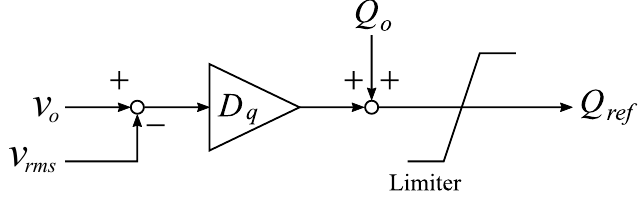
Figure 5. Block diagram of reactive power reference generation